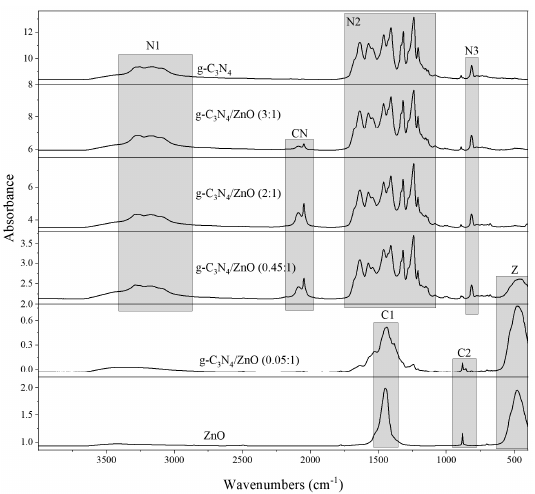
Figure 4. Infrared spectra of ZnO, g-C 3 N 4 , and g-C 3 N 4 /ZnO.